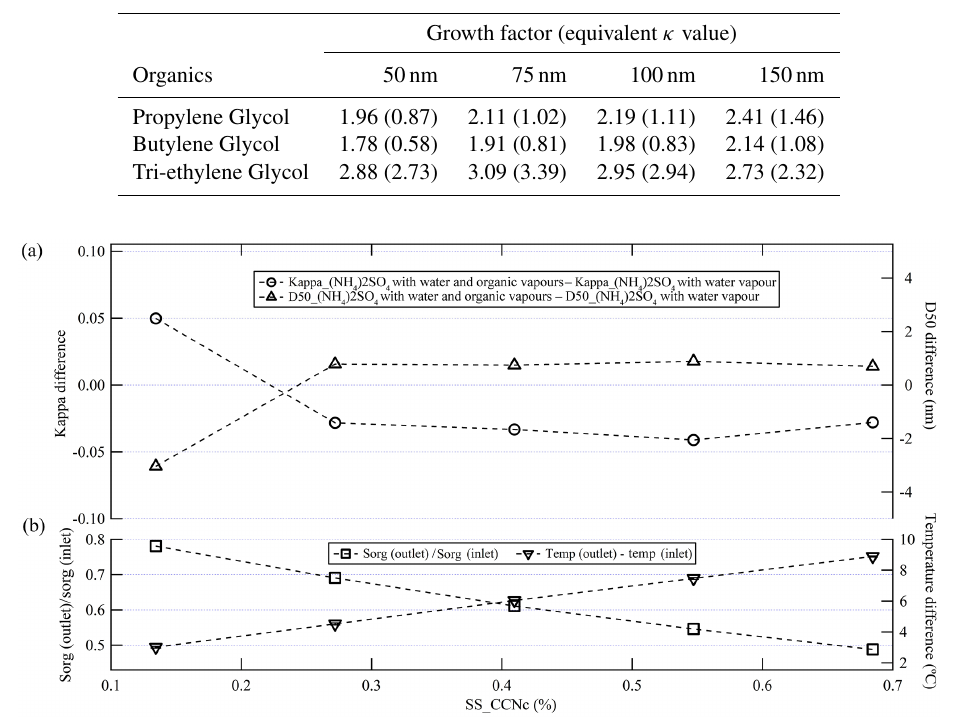
Table 2. Growth factor and the equivalent kappa of (NH 4 ) 2 SO 4 particles exposed in propylene glycol and water, butylene glycol and water, and tri-ethylene glycol and water vapours in a 2m glass reactor.